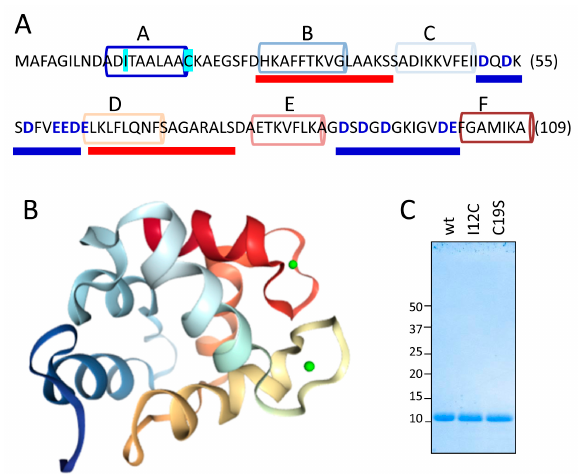
Figure 1. Structural features of the Gad m 1 chain. ( A ) Gad m 1 sequence and its dual folding signatures. Helical segments A–F forming the helix-loop-helix (AB, CD and EF) of EF-hands are depicted by colored cylinders. Acid loops binding Ca 2+ and joining C and D and E and F helices are underlined by a thick blue line. Regions forming the aggregated core of the amyloid fold are underlined by a thick red line. Residues used for mutant generation (I12C and C19S) are outlined in cyan. ( B ) Three-dimensional structure of Ca 2+ -bound Gad m 1 (PDB 2MXY). Helical segments are depicted using the color code used in panel A, and cations are depicted as green spheres. ( C ) Sodium dodecyl sulfate polyacrylamide gel electrophoresis (SDS-PAGE) gel of the recombinant Gad m 1 wild type (wt), I12C and C19S chains obtained after cleavage of the His-tag.